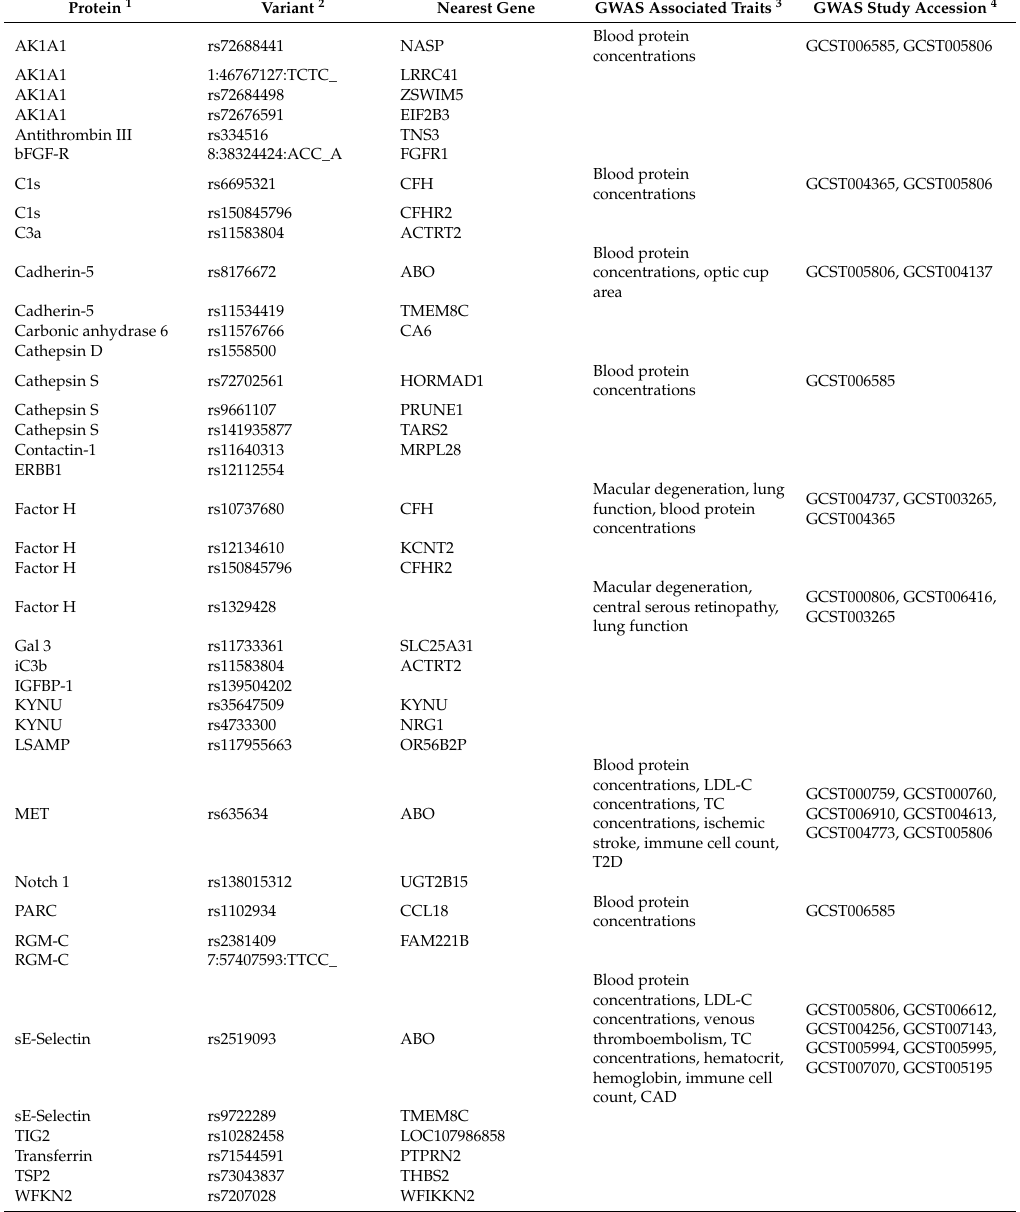
Table 5. Overlap among dietary protein quantitative trait loci and prior genome-wide association study risk loci.